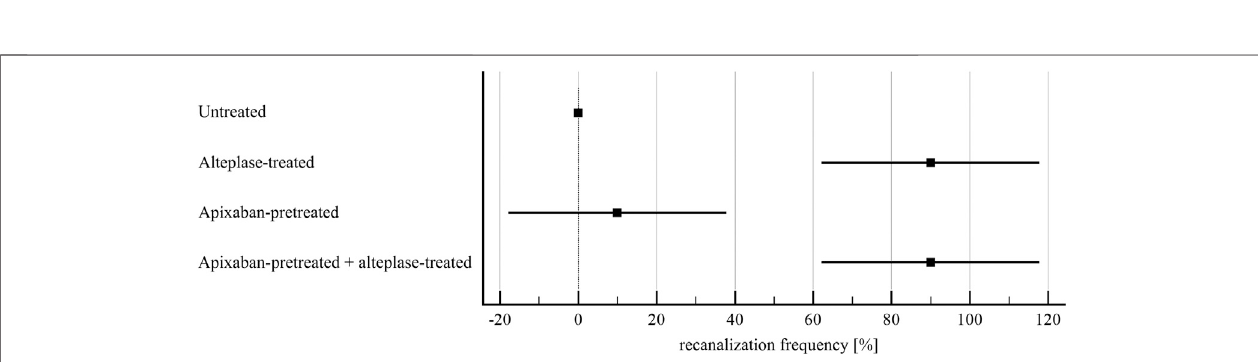
FIGURE 3 | Flow model: time to recanalization of in vitro vessel. The forest plot shows mean values (square) and 95% con fi dence interval (whiskers). n (cid:1) 9 – 10. Dashedlineshowsexperimenttimewindow.Resultsdemonstratethatalteplasetreatmentprovidedef fi cientthrombolysis,e.g.documentedaslowerrecanalizationtime comparedtountreatedgroup(107 ± 46 minvs.180 ± 0 min, p < 0.01).Forclotswithandwithoutapixaban,alteplase-inducedlysisdidnotdiffer,e.g.recanalizationtime was 127 ± 31 min vs. 107 ± 46 min, p (cid:1) 1.00. See Supplementary Table S3 for more details.